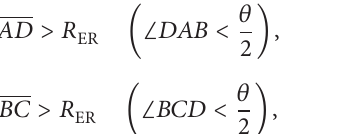
Figure 6: Concurrent transmission